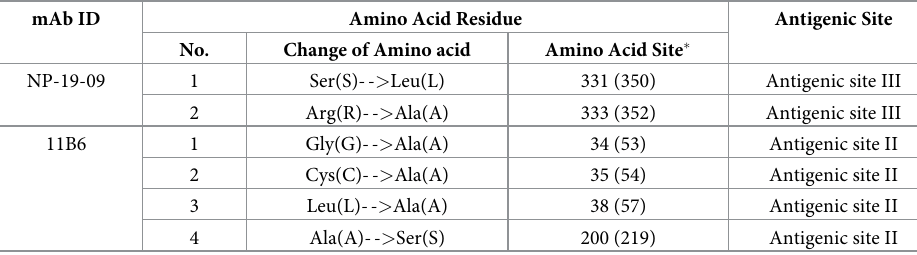
� Amino acid site excluding the signal peptide of rabies virus